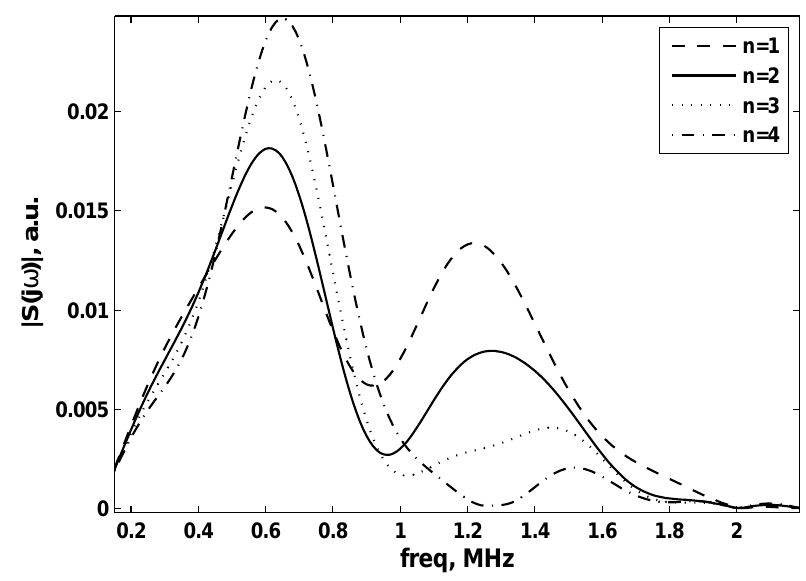
Figure 8. Fourier transform absolute values of signals situated at the sound beam border (Line 2) for different values of n (see also Figure